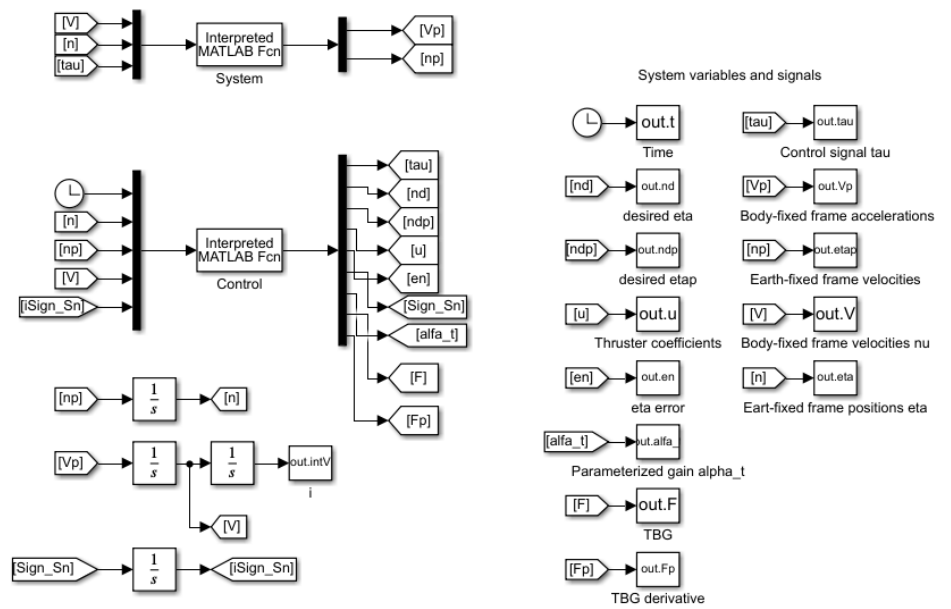
Figure 3. BlueROV2 simulator. Simulink block diagram.